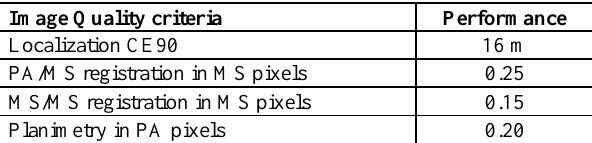
Table 1. Main Geometric Image Quality performances assessed 2012, April, 5 th